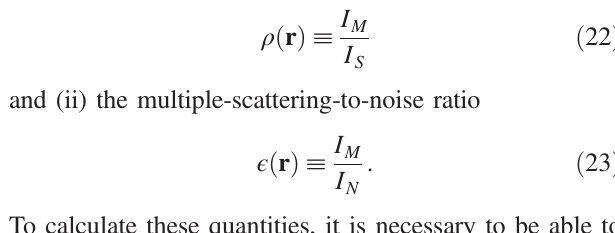
FIG. 5. Local mapping of multiple scattering. Normalized mean intensity profiles for (a) the focused basis I ð r ; Δ θ Þ are displayed for the different areas highlighted in (c) the corresponding ultrasound image (formed using the two-layer field I av model in Sec. III A). Maps of multiple-scattering rates (d) ρ ð r Þ [Eq. (22)] and (e) ϵ ð r Þ [Eq. (23)] are shown, superimposed on the ultrasound image. Some structures in the bovine tissue layer (indicated by white arrows) cause a significant amount of multiple scattering to occur behind them (outlined by dashed lines). The solid lines outline the image area that suffers from artifacts due to the double-reflection event between the probe and the bovine tissue – phantom